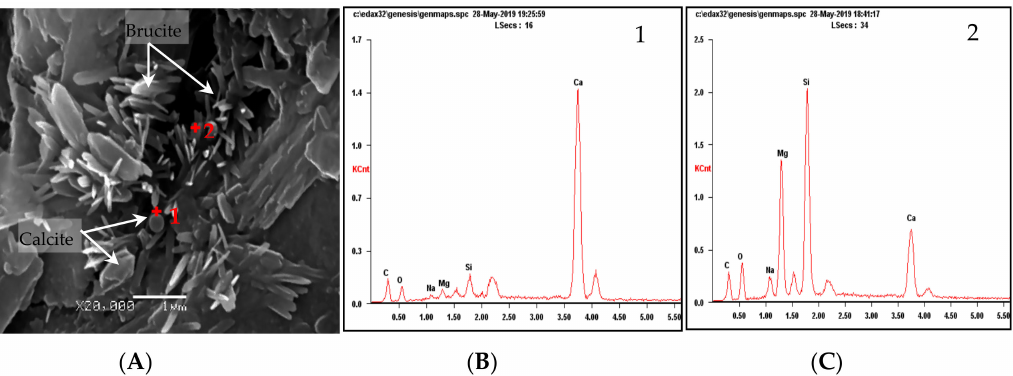
Figure 12. BSE and EDS images of products in concrete bars cured in 1 mol / L NaOH at 80 ◦ C: ( A ) BSE image of the products; ( B ) EDS image of calcite; ( C ) EDS image of brucite.